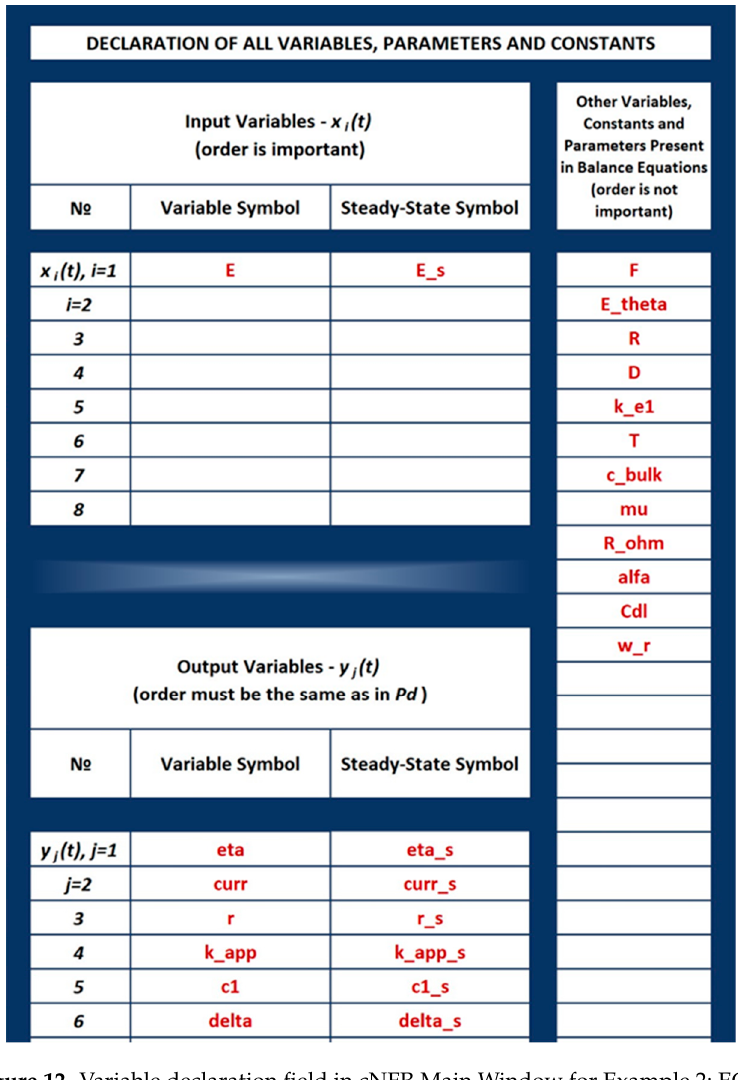
Figure 12. Variable declaration field in cNFR Main Window for Example 2: ECR.